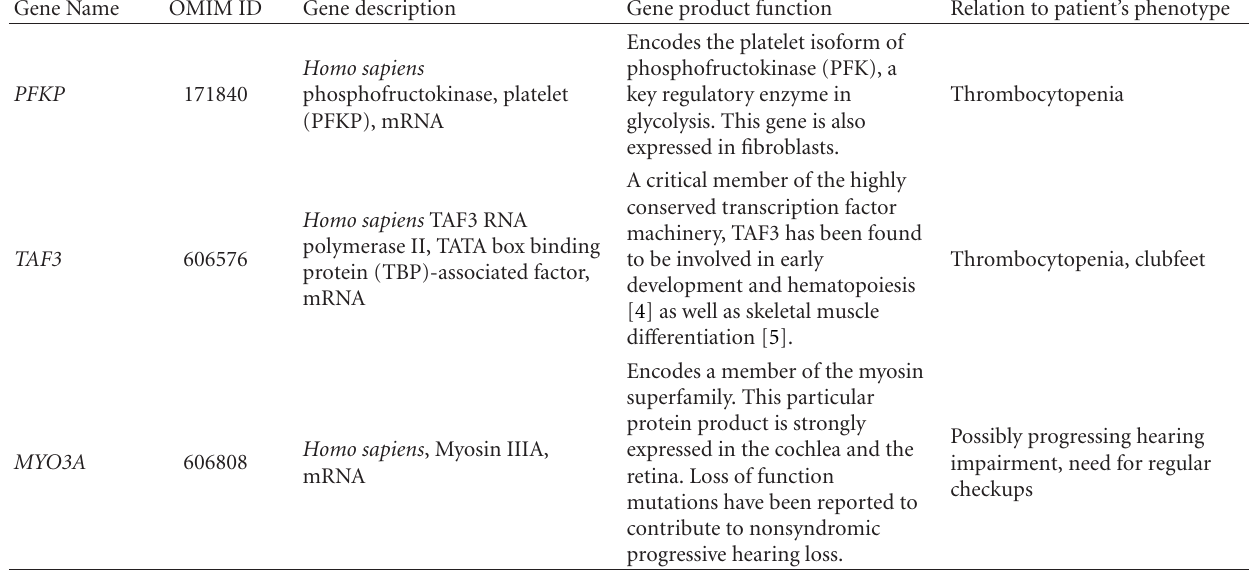
Table 2: Potentially causative genes on chromosome 10p11.22p15.3 that may play a role in our patient’s phenotypic